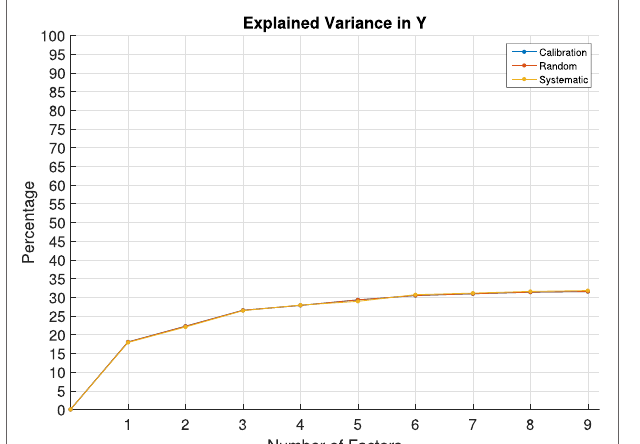
FIGURE 8 | Standard PLSR results.